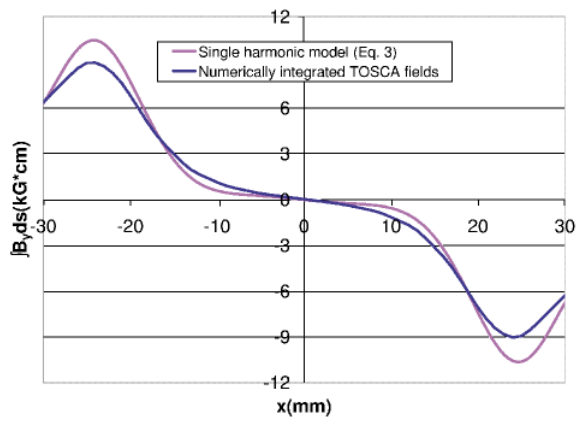
FIG. 2. (Color) Field integral along wiggling trajectory.